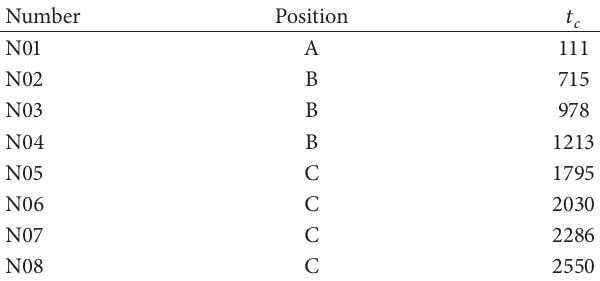
Table 3: Labels of the PIV measurements performed (N01 to N07), FOV (A to C), and central sampling time 𝑡 𝑐